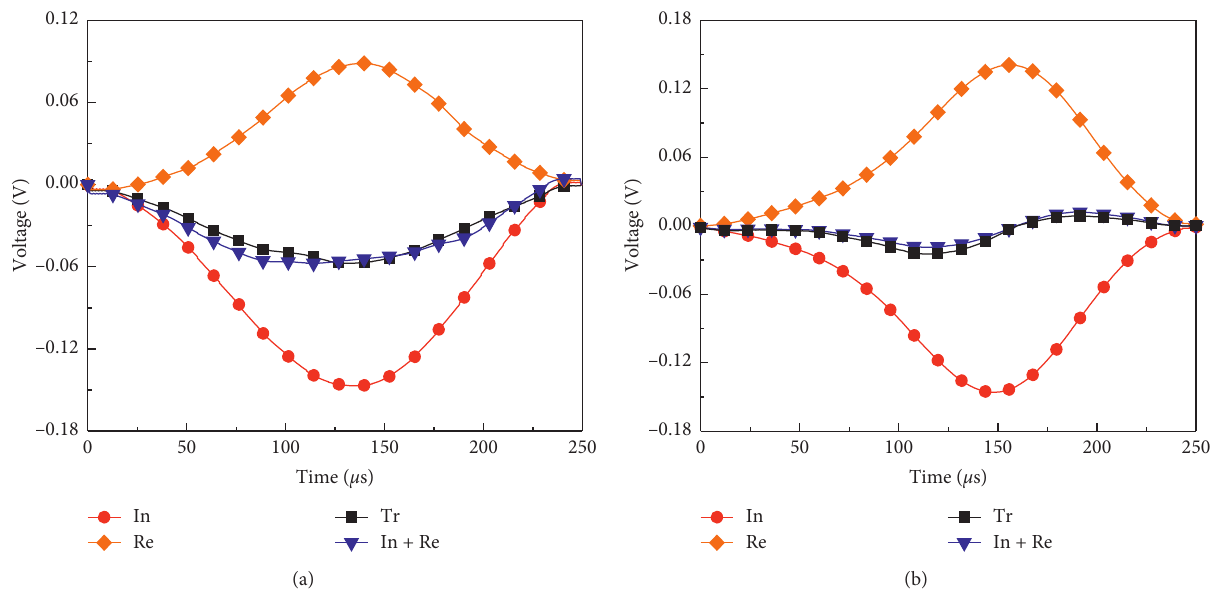
Figure 4: Dynamic force equilibrium check. (a) Cyclic impact loading tests. (b) Dynamic three-point bending test.